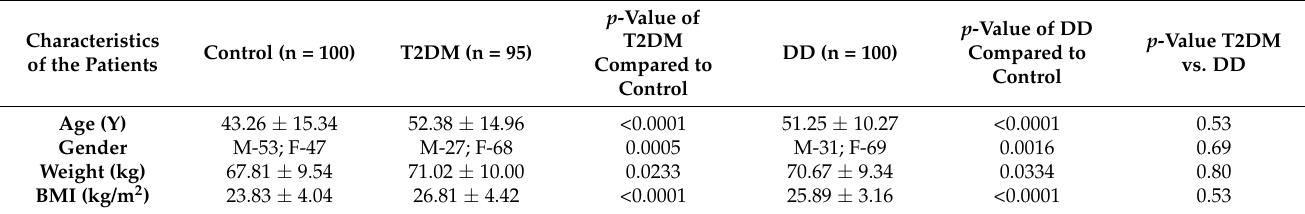
Table 1. Characteristics of the